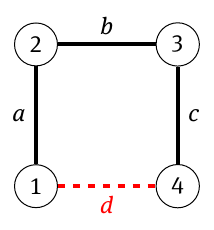
Figure 1: A weighted 4-cycle with three positive edges and one negative edge. Solid black lines are positive edges and the dashed red line is the negative